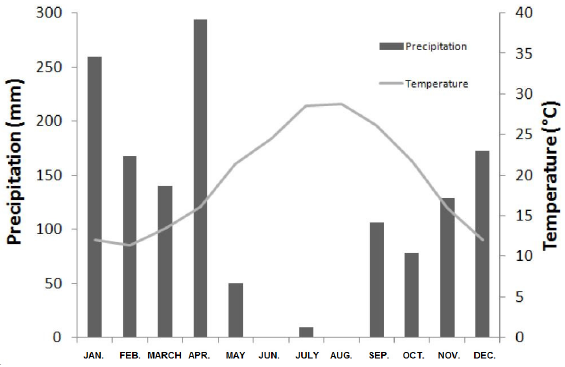
Figure 2. Climate diagram for the 2008–2009 period in the Bellif study site, representing monthly precipitations (bars) and mean temperatures (grey line).